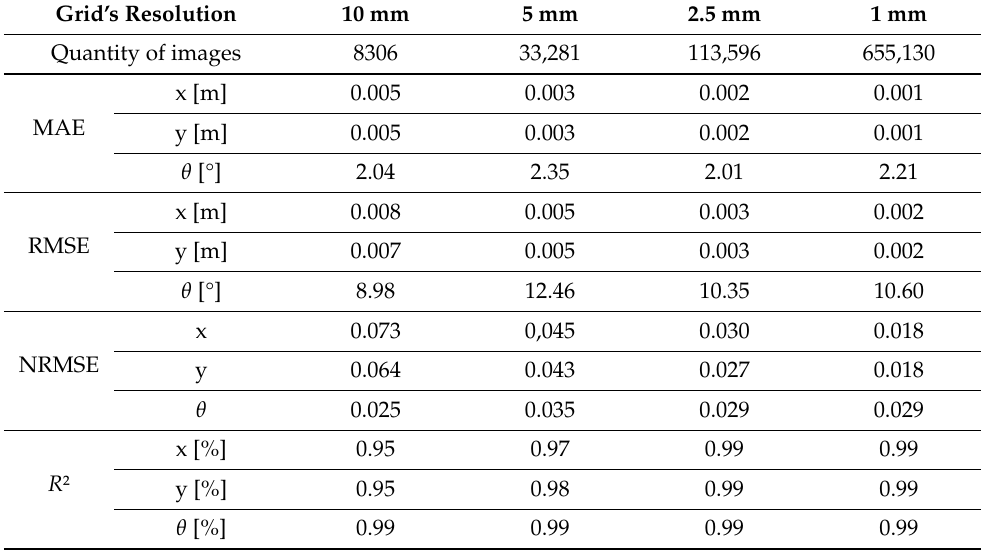
Table 3. Results 1 using different grid resolutions. The algorithm used to obtain these results was the Random Forest Regressor.